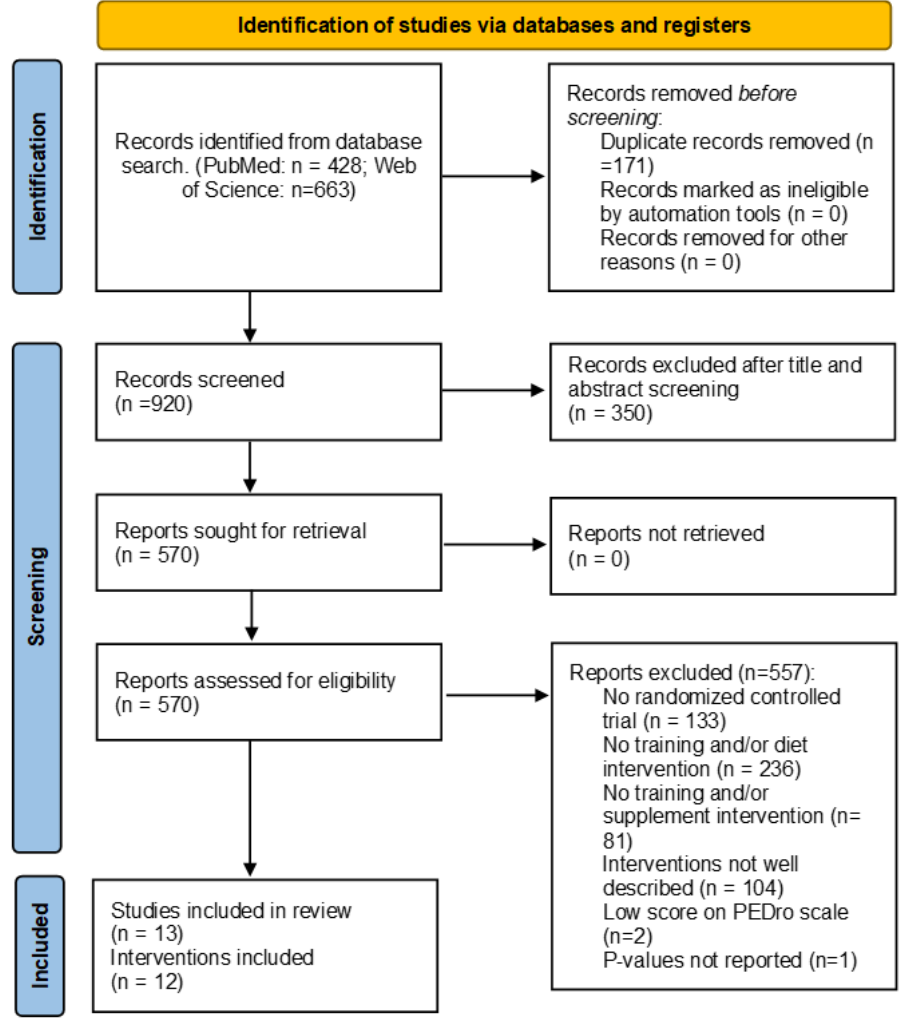
Figure 1. PRISMA flow diagram for the Systematic Review.